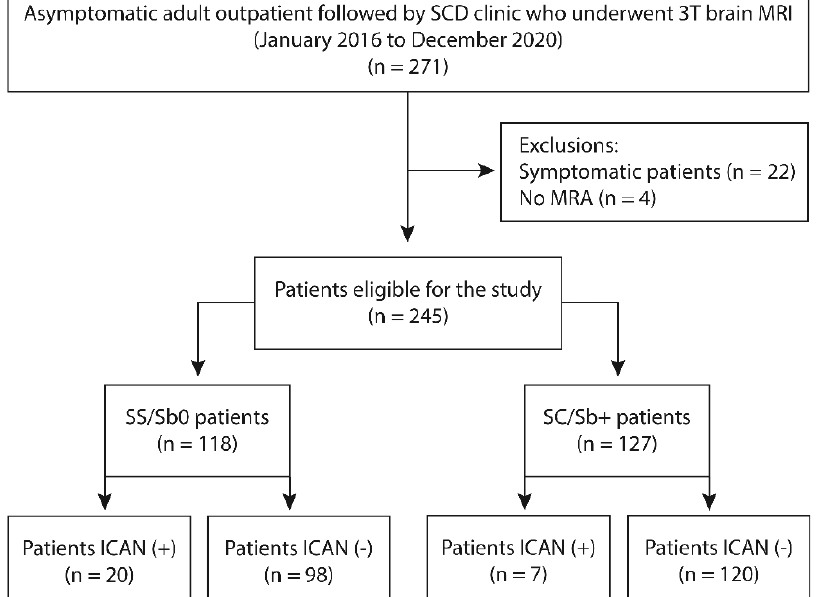
Figure 1. Flowchart of patients included in the study. SCD: Sickle cell disease; MRI: Magnetic resonance imaging; ICAN: intracranial aneurysm; SS/Sb0 = SS/S- β 0thalassemia genotype; SC/Sb+ = SC/S- β + genotypes.